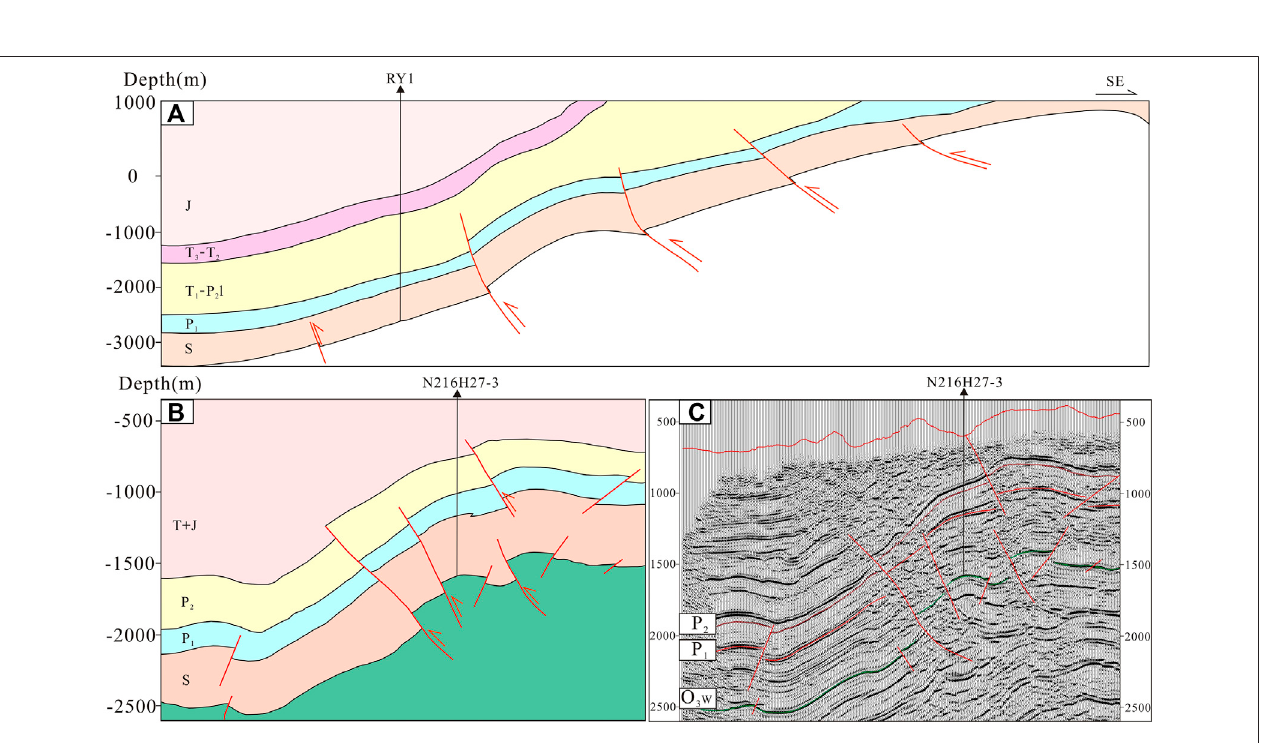
Frontiers in Earth Science |